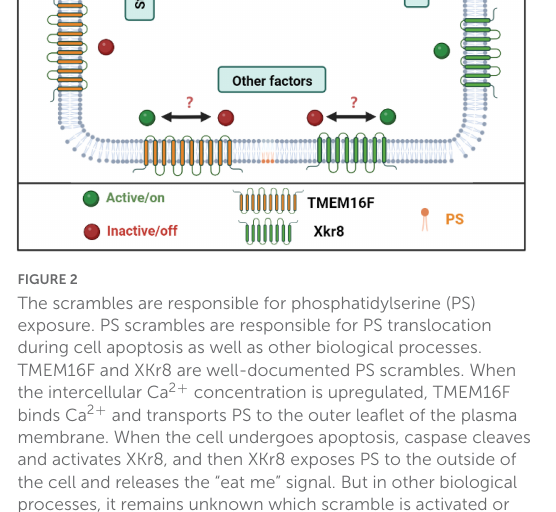
the apoptotic cells or other biological processes, the flippases are disrupted by caspase or inhibited by Ca 2 + ; at the same time, either TMEM16F or XKR8 is activated to expose PS and participate these biological processes (Nagata et al.,